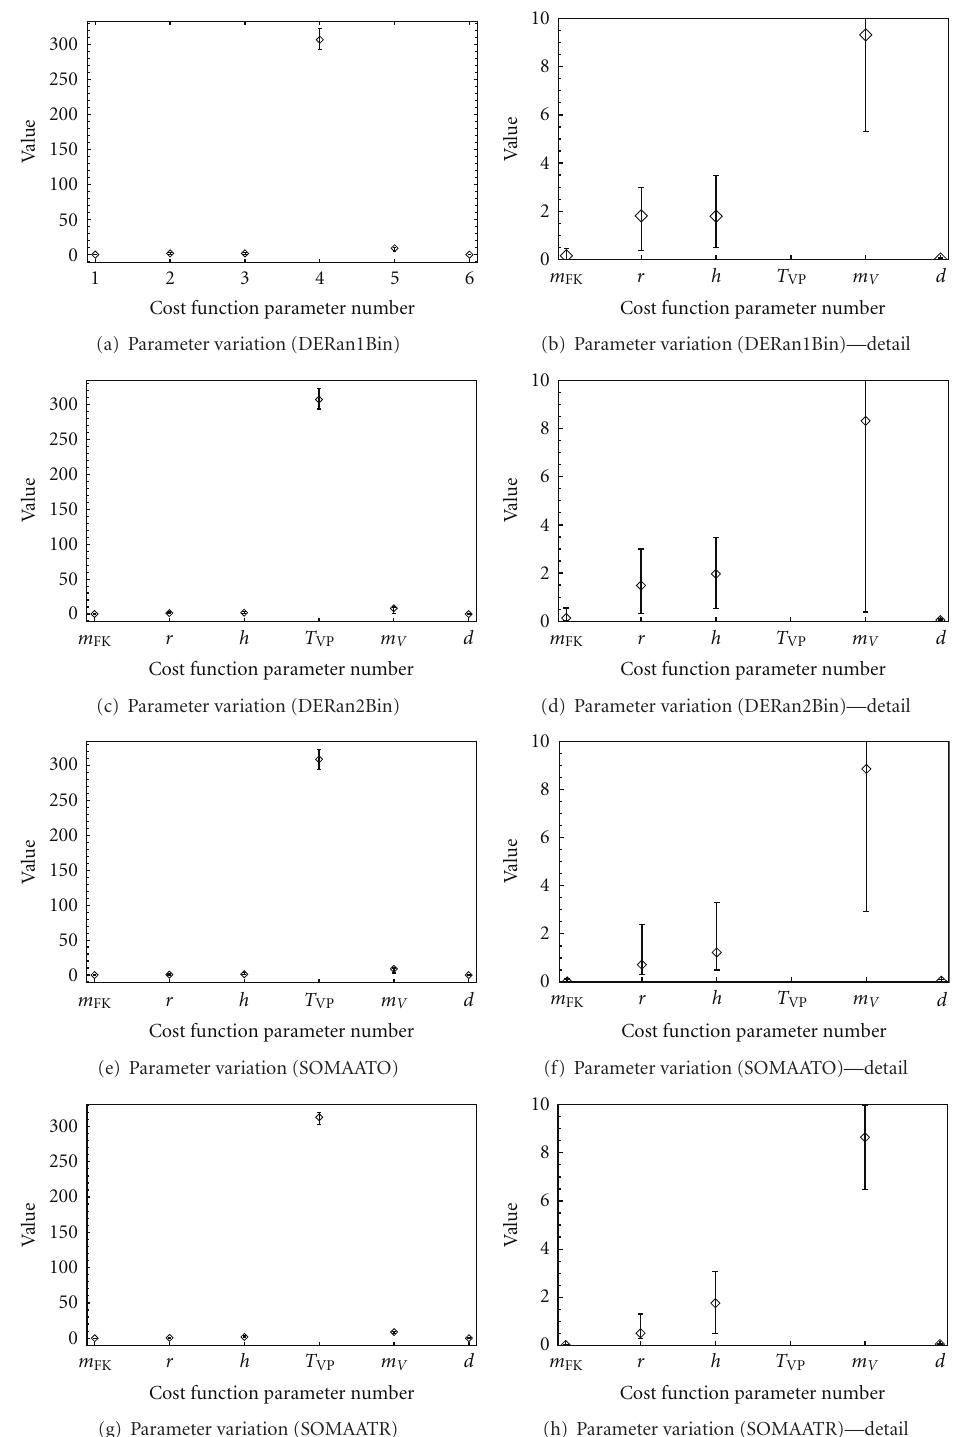
Figure 3: Parameter variation of SOMA and